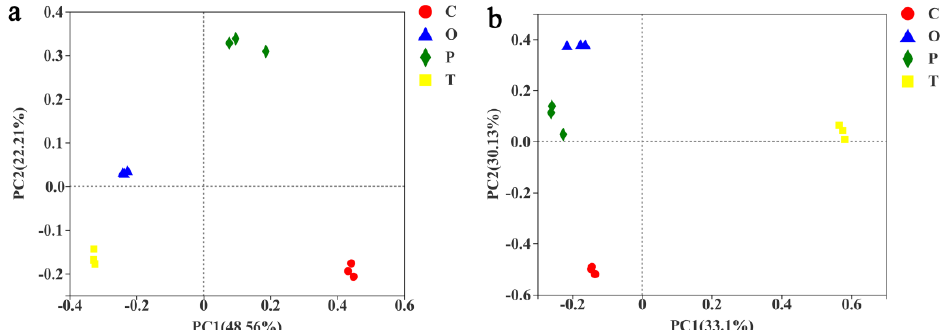
Figure 4. Soil microbial community structure in four moss-dominated biocrusts. Principal Coordinate Analysis (PCoA) of 16S rRNA and ITS rRNA diversity used in this study. ( a ) Soil bacterial community. Moss species explained 48.56% of the total variability in the bacterial community composition (PERMANOVA, p < 0.001). ( b ) Soil fungal community. The species of moss determined 33.10% of the total variability in the agricultural soil (PERMANOVA, p < 0.001). CSS transformed reads were used to calculate Bray–Curtis distances in ( a , b ). Red color was assigned to Claopodium rugulosifolium soil and cyan to Orthotrichum courtoisii soil and green to Polytrichum formosum soil and yellow to Taxiphyllum giraldii soil. C: Claopodium rugulosifolium ; O: Orthotrichum courtoisii ; P: Polytrichum formosum ; T: Taxiphyllum giraldii